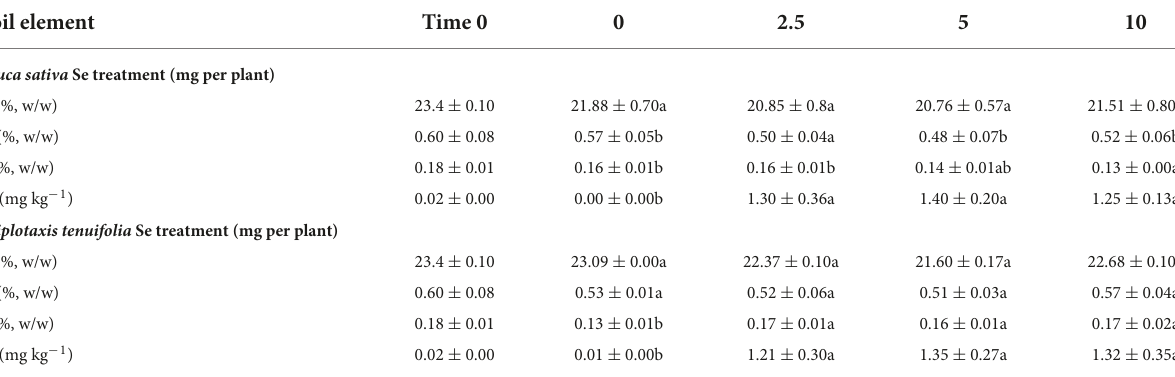
TABLE 3 Content of total C, N, S and Se in soil where rocket species ( Eruca sativa and Diplotaxis tenuifolia ) were grown in soil and foliarly fertilized with selenate dosages ranging from 0 to 10 mg per plant. Soil